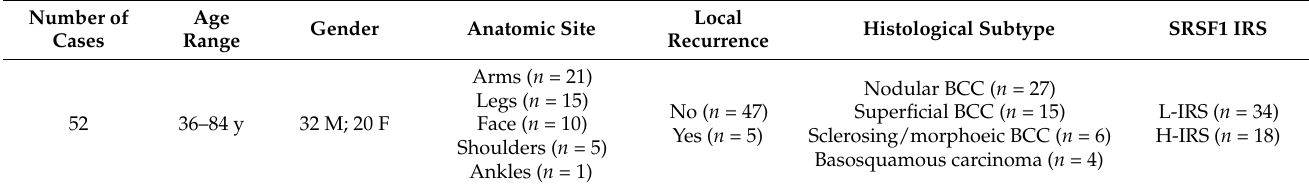
Table 1. Clinico-pathological and immunohistochemical features of the BCCs from our